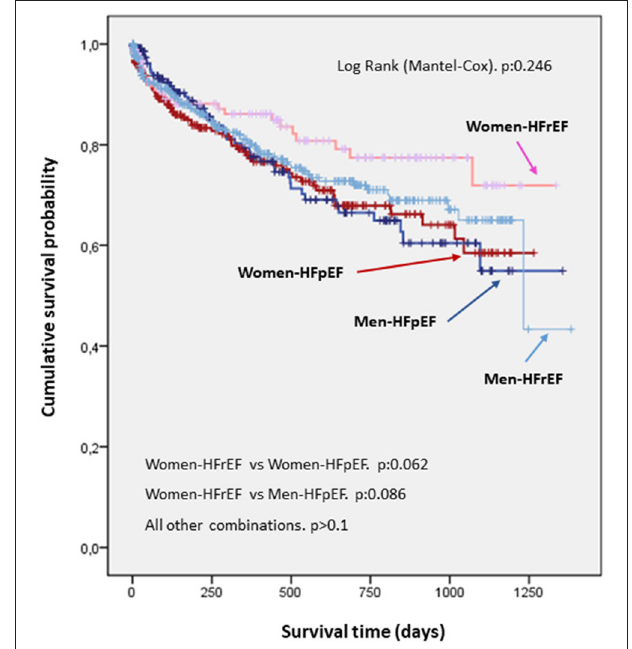
FIGURE 3 | Survival curve by sex and by left ventricular ejection fraction. No differences were observed in probability of survival by sex and by LVEF. Nevertheless, there was a trend for women with HFrEF to have a better prognosis. HFrEF, Heart failure with reduced ejection fraction; HFpEF, Heart failure with preserved ejection